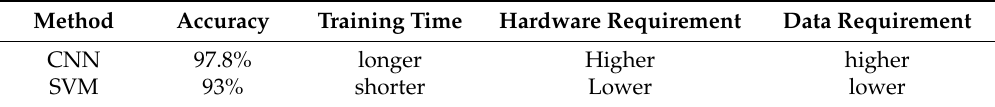
Table 3. Comparison of CNN and SVM methods.